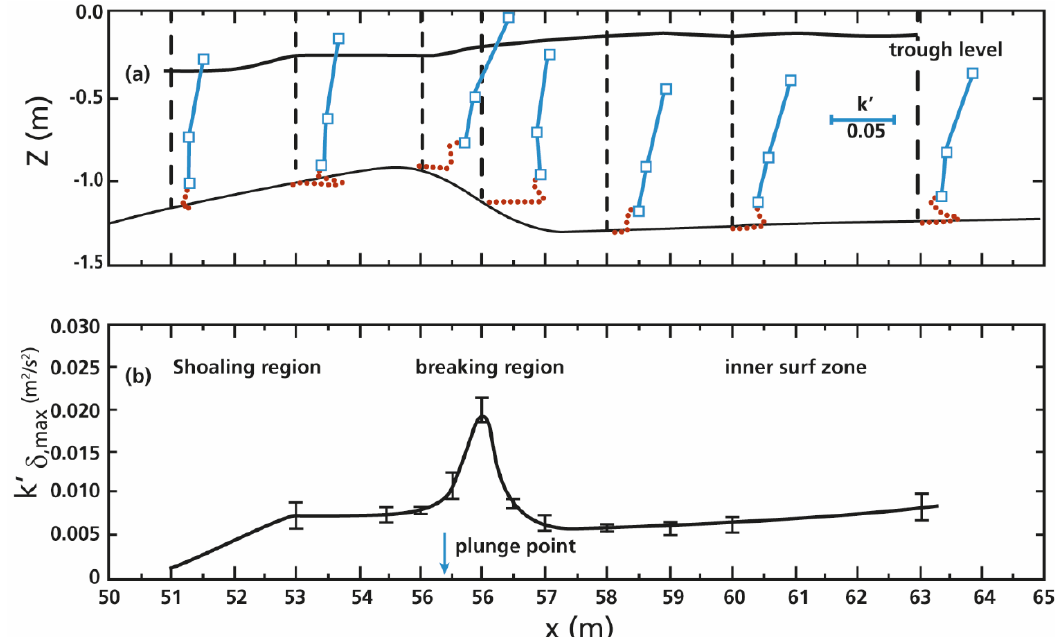
Figure 9. ( a ). Cross-shore evolution of the vertical < k ’>-structure under monochromatic waves measured by ADVs (blue line and squares) and ACVP (red dots) in a laboratory facility. The cross-shore profile is shown for reference. ( b ). Maximum < k ’> measured within the wave boundary layer. Modified from van der Zanden et al. [63].